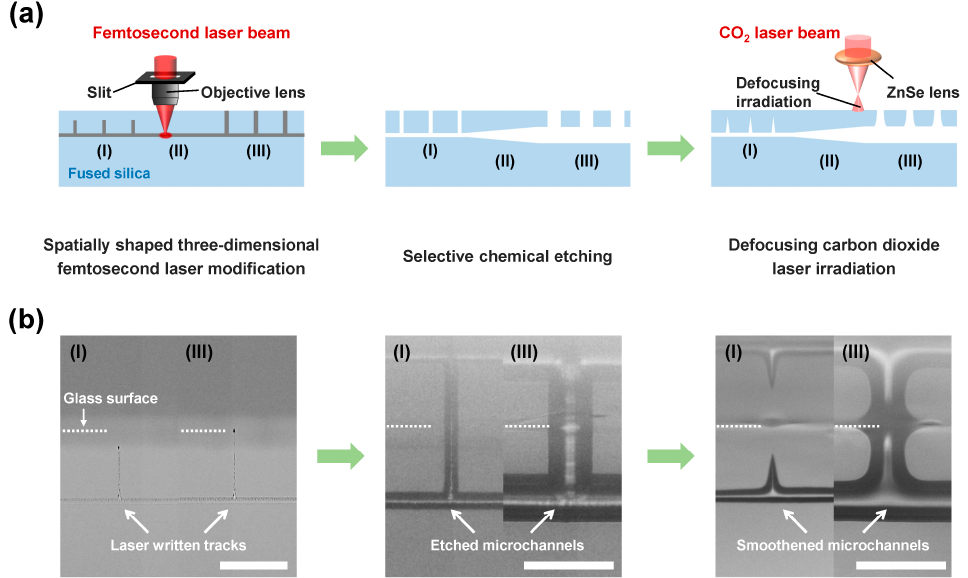
Figure 1. ( a ) Schematic of the fabrication procedure for a spot-size converter channel structure in fused silica glass, which consists of three main steps: spatially shaped three-dimensional fs laser modification (left), selective chemical etching (middle), and defocusing CO 2 laser irradiation (right). In the left panel, gray lines represent laser-written tracks, which include the left vertical lines beneath the glass’s surface with a depth of ~18 μ m (region I), a horizontal line embedded in glass with a depth of ~100 μ m (region II), and the right vertical lines directly exposed on the glass surface (region III). In the middle panel, the sizes of the etched channel and the extra-access ports on the left (region I) are smaller than those on the right (region III), as the preferential etching of the laser-written tracks on the right occurs, which leads to the formation of the tapered channel structure in the middle (region II). In the right panel, the internal surface of the whole channel is smoothed by CO 2 laser irradiation. ( b ) Side-view optical micrographs of the corresponding glass microstructures at each step in ( a ). White dashed lines and scale bars in ( b ) represent the glass surface and 100 μ m, respectively. 3. Results and Discussion 3.1. Fabrication of 3D Tapered Channel Structures Figure 2a shows top-view optical micrographs of the etched tapered microchannel structure (region II) before and after CO 2 laser irradiation. Before CO 2 laser irradiation, the diameters of the left and right ends of the tapered channel in region II were about 15 μ m and 58 μ m, respectively, which were the same as the diameters of two straight channels in region I and region III. The formation of a tapered microchannel structure was mainly due to the spatially asymmetric etching based on the etching selectivity. To create etching asymmetry, the vertical lines and the horizontal line in region III connected to the glass surface were preferably etched to form a hollow microchannel in region III, and the etching of the horizontal line in region II was then triggered from the right side. With the increase in the etching time, the gradient etching of the horizontal line in region II was carried out before the glass matrix above the vertical lines in region I was etched away. Finally, after etching the straight channel in region I, a 1.3 mm-long tapered channel structure with a taper angle of 1° was obtained. After CO 2 laser irradiation, the size of the whole tapered microchannel structure exhibited uniform shrinkage with a nearly unchanged taper angle (~1°). As shown in the right panel of Figure 2a, the diameters of the left and right ends of the tapered channel decreased to 9 μ m and 50 μ m, respectively. Moreover, the inner surfaces of the whole channel structures were smoothed by direct CO 2 laser writing, which can be identified from the right panels of Figure 2a–c. As the fused silica had strong absorption of the laser energy at a wavelength of ~10.6 μ m, the temperature of the laser-irradiated area rapidly increased under the CO 2 laser heating, and then the molten pool generated in situ on the glass surface combined with the thermal